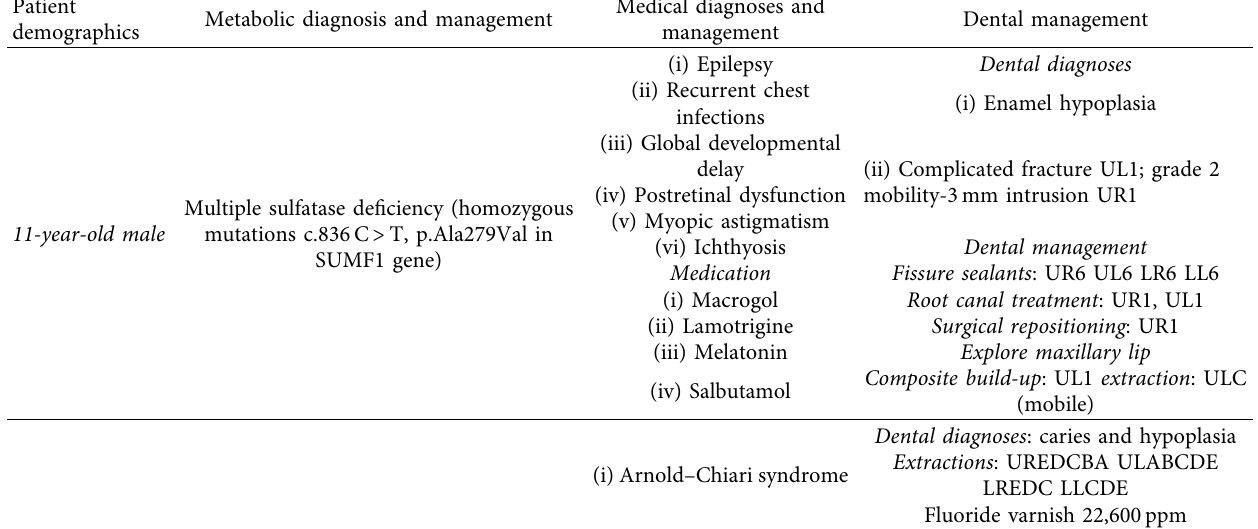
Table 2: Metabolic, medical, and dental diagnoses and management of the two siblings.